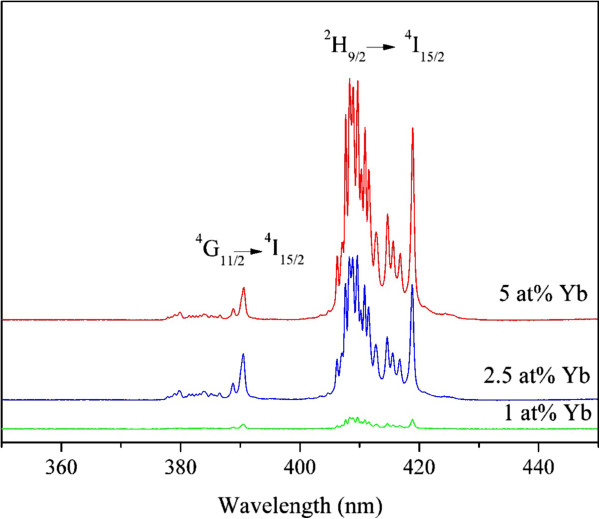
UC spectra of NPs in UV-blue spectral region after excitation with 978-nm radiation. Y1.97Yb0.02Er0.01O3 (green line), Y1.94Yb0.05Er0.01O3 (blue line), and Y1.89Yb0.10Er0.01O3 (red line).